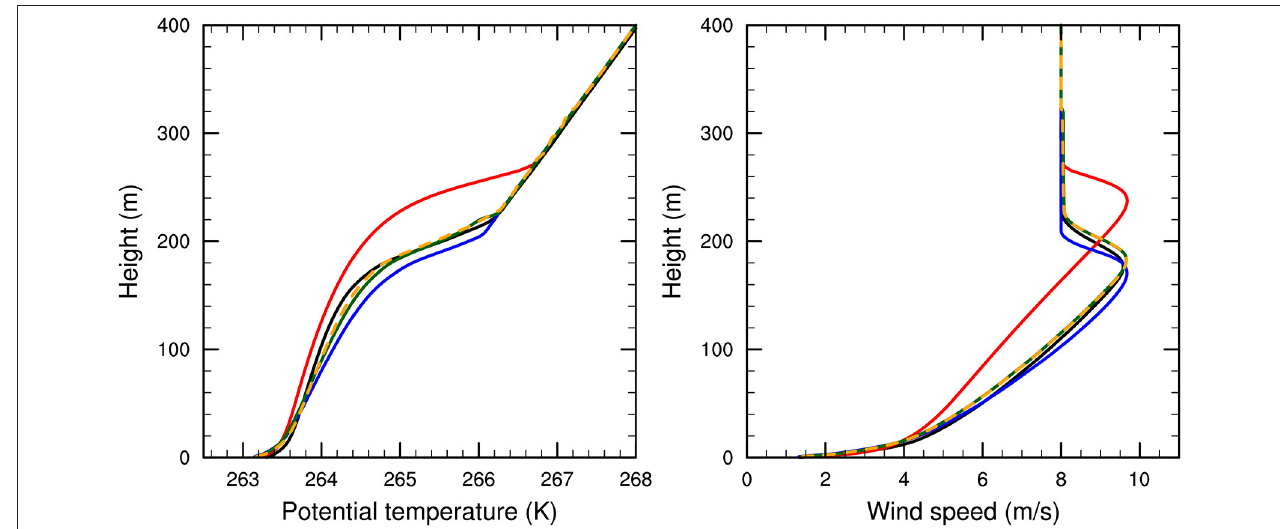
FIGURE 1 | Mean potential temperature (Left) and wind speed (Right) averaged over the final hour (8–9thh) of the GABLS1 case: the LES with 2-m resolution (black), the reference SCM with the BL89 mixing length (red), the SCM with LES-forced L m (blue), the SCM with LES-forced L m and L ǫ (green), and the SCM with LES-forced L m , L ǫ , and ψ h (dashed